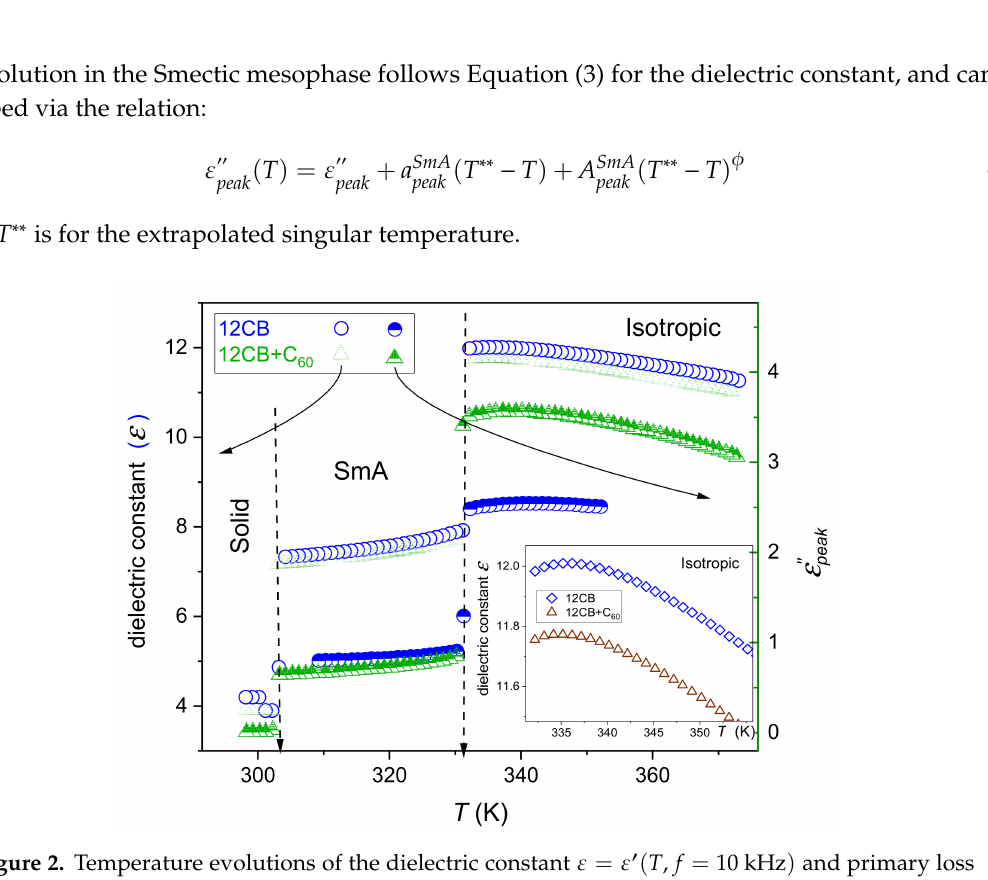
Figure 2. Temperature evolutions of the dielectric constant ε = ε (cid:48) ( T , f = 10 kHz ) and primary loss ( f , T ) , 100 Hz < f < 1 GHz for 12CB and 12CB + C curves’ maxima ε (cid:48)(cid:48) 60 fullerene (0.1% mass fraction) peak nanocomposite. The inset shows the behavior of the dielectric constant in the isotropic liquid phase, for the immediate vicinity of the clearing